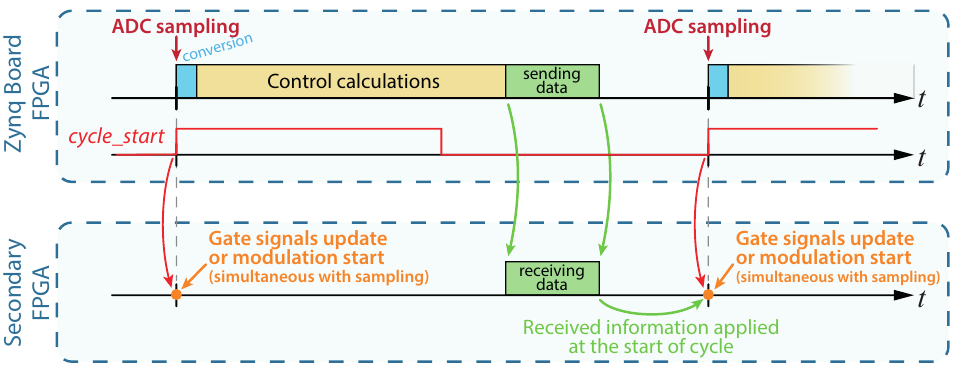
Figure 3. Proposed synchronization mechanism for outputs managed by the secondary